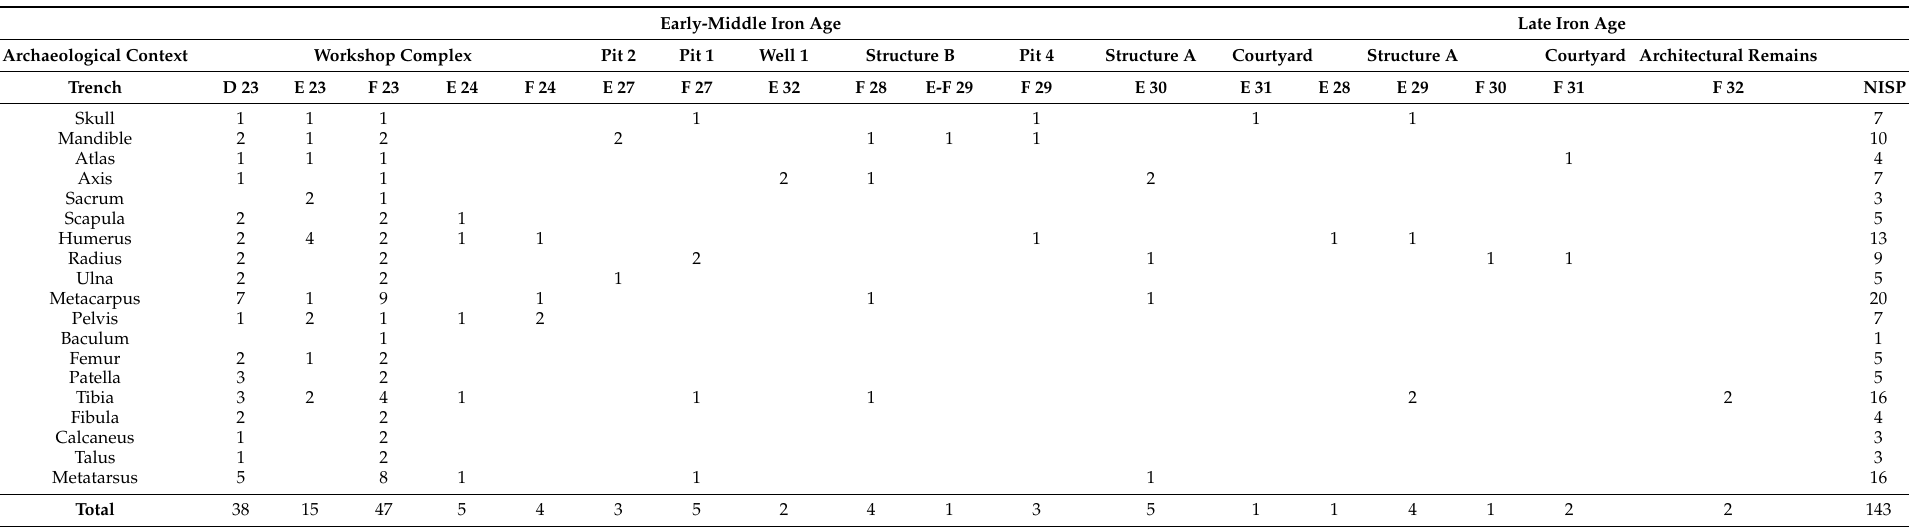
Table 2. Distribution of the anatomical elements of the Alaybeyi dogs examined in this